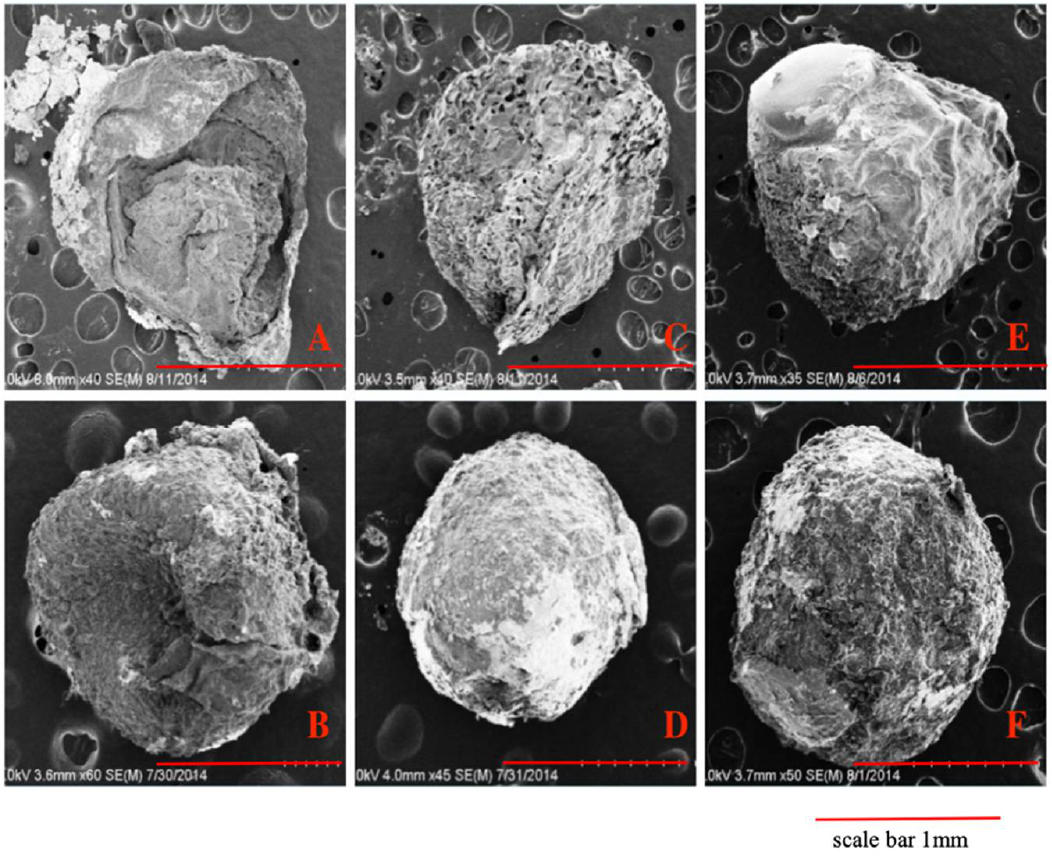
Figure 1. SEM images of pure chitosan hydrogel beads with increased chitosan concentration ( A , C , E ) and chitosan / Halloysite nanotubes (HNTs) wt. / wt. composites ( B , D , F ). ( A ) 3% chitosan (CS), ( B ) 3% CS / 2% HNTs, ( C ) 4% CS, ( D ) 4% CS / 2% HNTs, ( E ) 5% CS, ( F ) 5% CS / 2% HNTs.